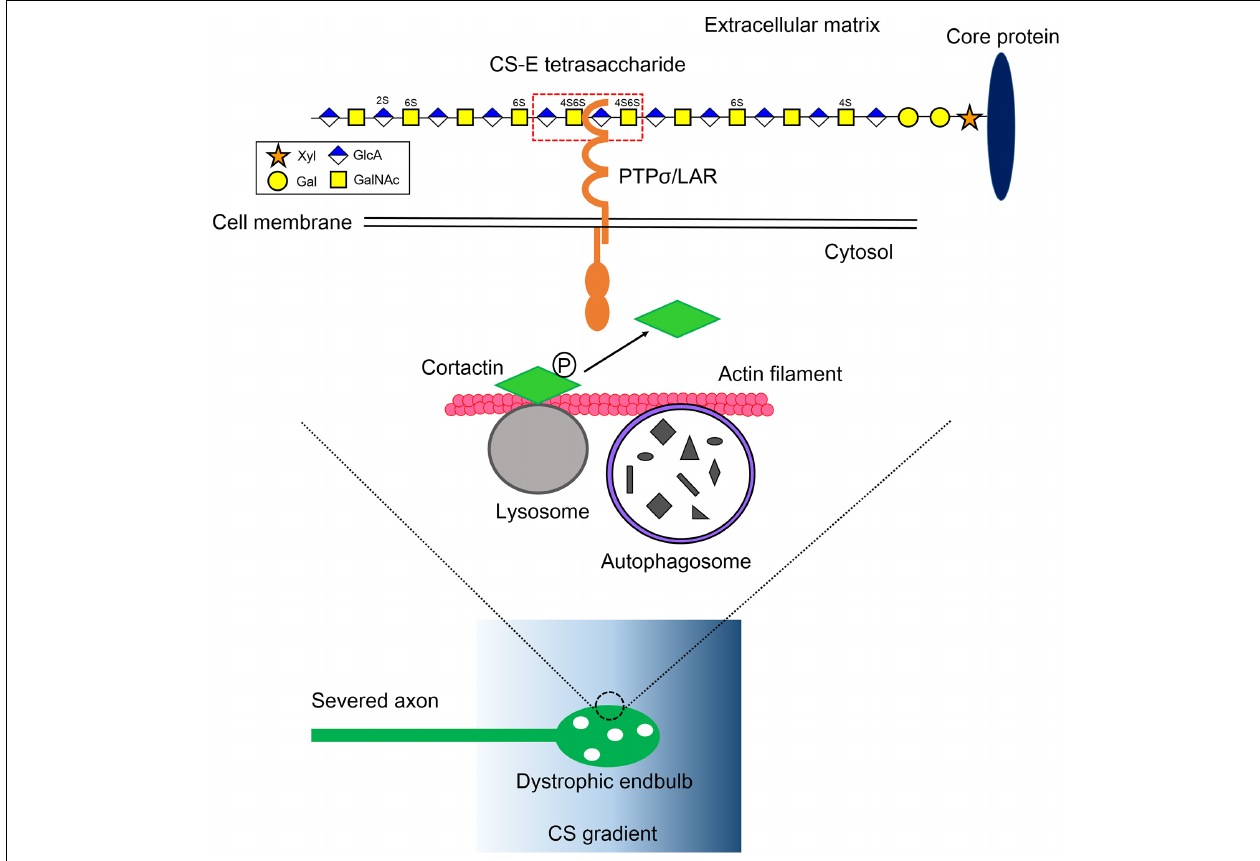
FIGURE 1 | Mechanistic insight into the formation of dystrophic endbulb by CS. The severed axons run into the gradient of CS originated from the perineuronal net and the reactive astrocyte in the lesion. The CS-E tetrasaccharide segment, which rarely appears on a CS chain, preferentially monomerizes and activates its axonal receptor PTP σ /LAR. Contrary, HS protects the formation of dystrophic endball by inducing clustering of the receptors. RPTP dephosphorylates cortactin, which is localized onto the lysosome surface and stabilizes actin fibers to facilitate autolysosome formation. As a consequence, the CS-RPTP axis disrupts autophagy flux, inducing the failure of fusion between autophagosomes and lysosomes, and thus abnormal accumulation of autophagosomes. That leadsto transforms of axon tips to dystrophic endbulb. Xyl, xylose; Gal, galactose; GlcA, glucuronic acid; GalNAc, N- acetylgalactosamine; P, tyrosine